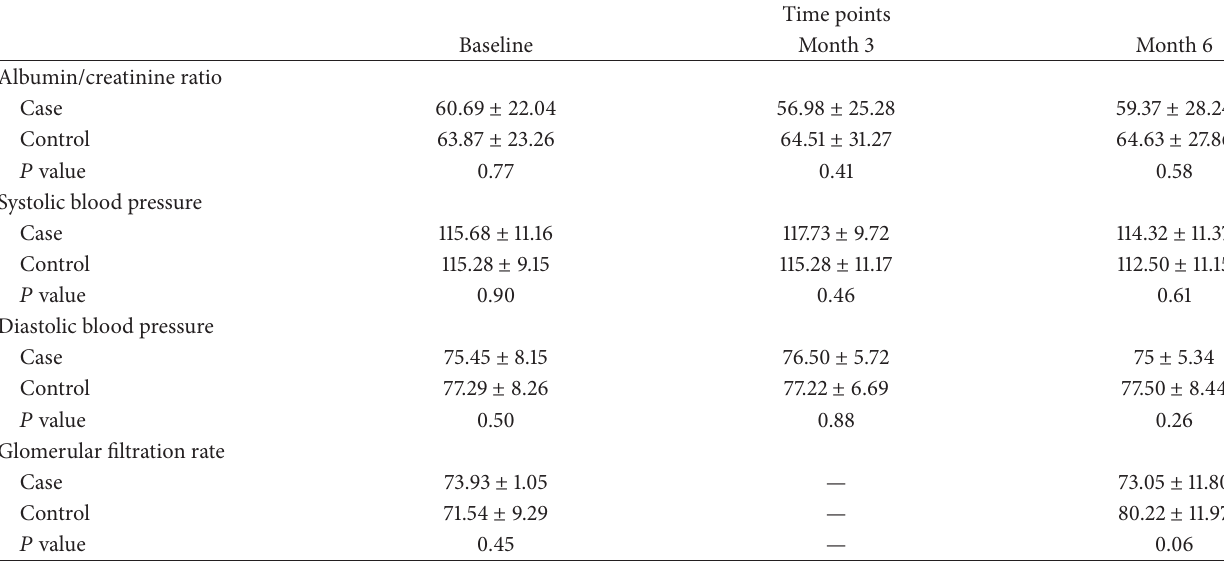
Table 2: Parameters of patients during the study.